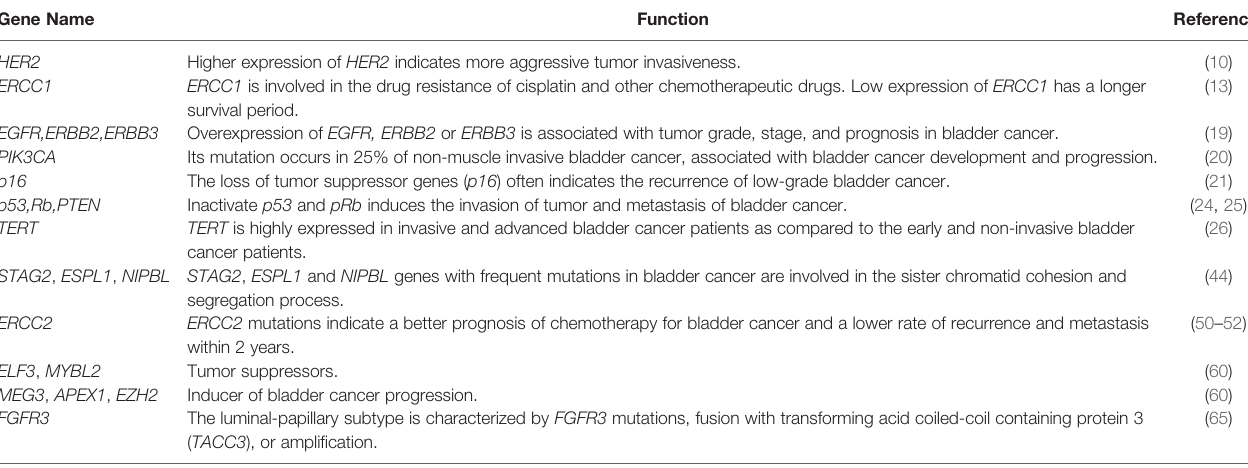
TABLE 1 | Common gene alterations in bladder